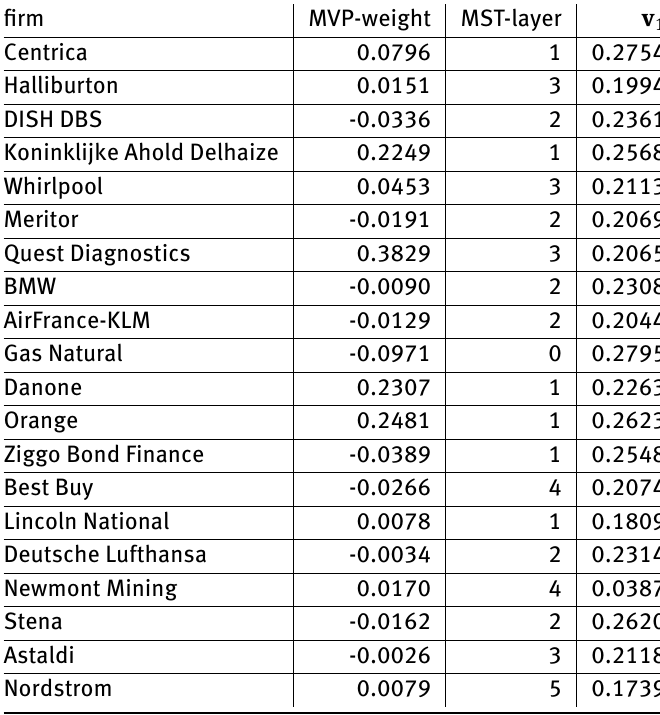
Table 4: The following portfolio exhibits a systematic underweighting of leaves, respectively peripheral assets, in the consid- ered time period: ˜ e d ( Σ ) = 0.2392 , ˜ f d ( Σ ) = 0.8847 , ˜ h d ( Σ ) = 0.8777